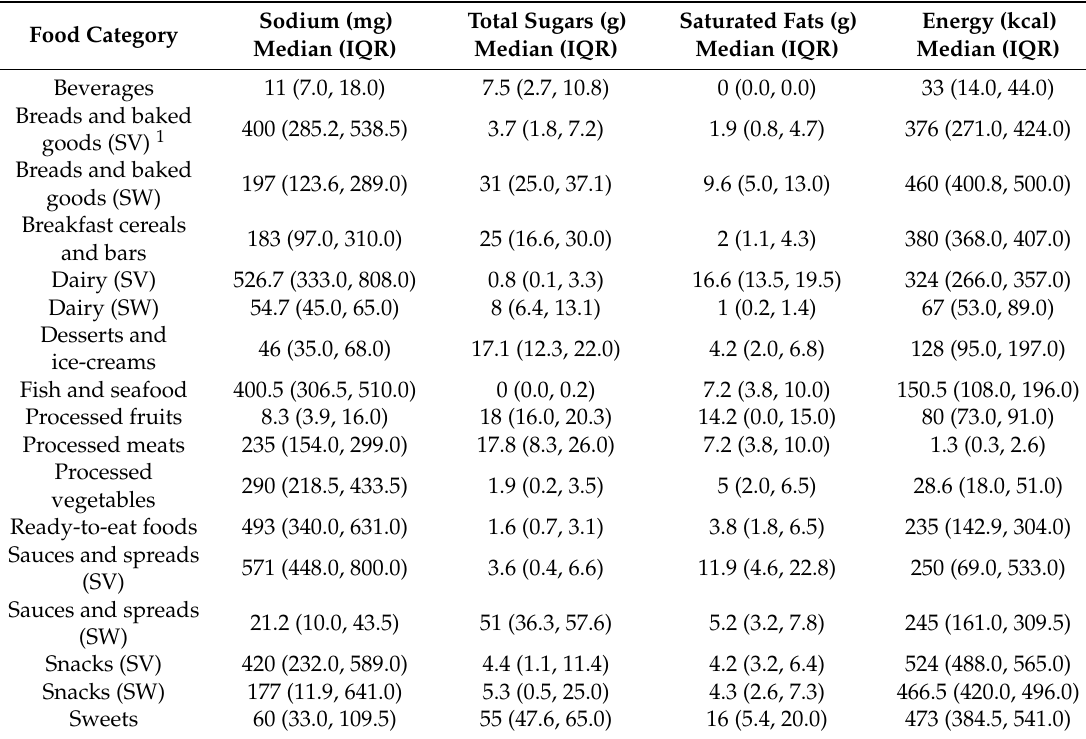
Table 3. Nutrient composition by food